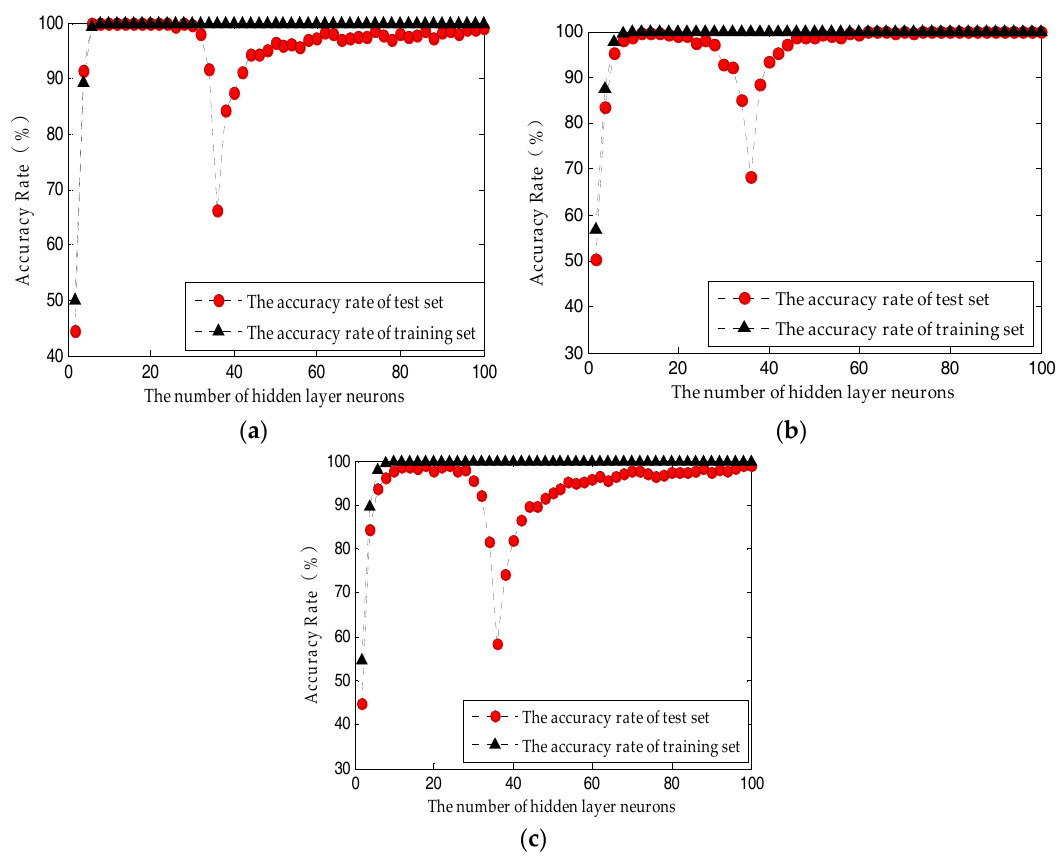
Figure 7. The influence of the number of hidden layer neurons on ELM performance: ( a ) Based on the PCA-optimized feature set; ( b ) Based on the PLS-optimized feature set; ( c ) Based on the original feature set.